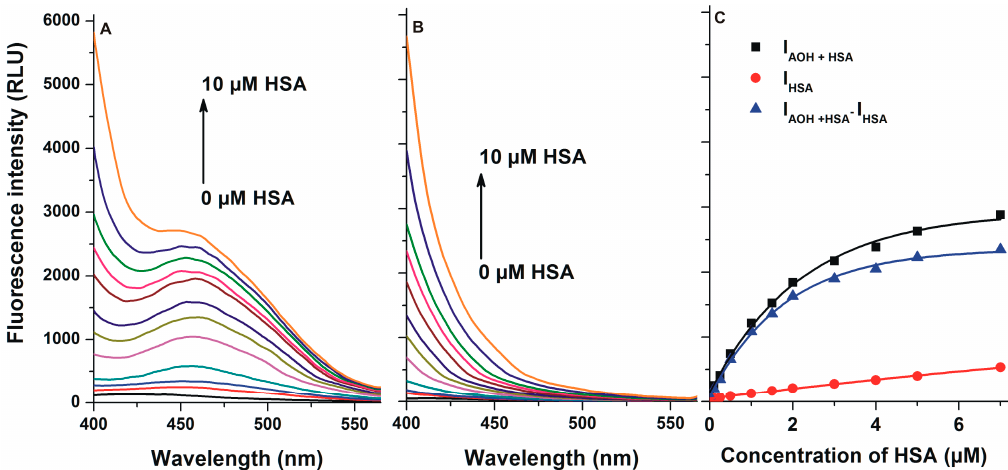
Figure 5. ( A ) Fluorescence emission spectrum of AOH (1 μ M) in the presence of increasing concentrations of HSA (0.0, 0.1, 0.25, 0.5, 1.0, 1.5, 2.0, 3.0, 4.0, 5.0, 7.0, and 10.0 μ M) in PBS (pH 7.4); ( B ) Fluorescence emission spectrum of increasing concentrations of HSA (0.0, 0.1, 0.25, 0.5, 1.0, 1.5, 2.0, 3.0, 4.0, 5.0, 7.0, and 10.0 μ M) in PBS; ( C ) Fluorescence emission intensity of AOH in the presence of increasing concentrations of HSA (I AOH+HSA ), HSA alone (I HSA ), and I AOH+HSA – I HSA ( λ ex = 295 nm, λ em = 455 nm).